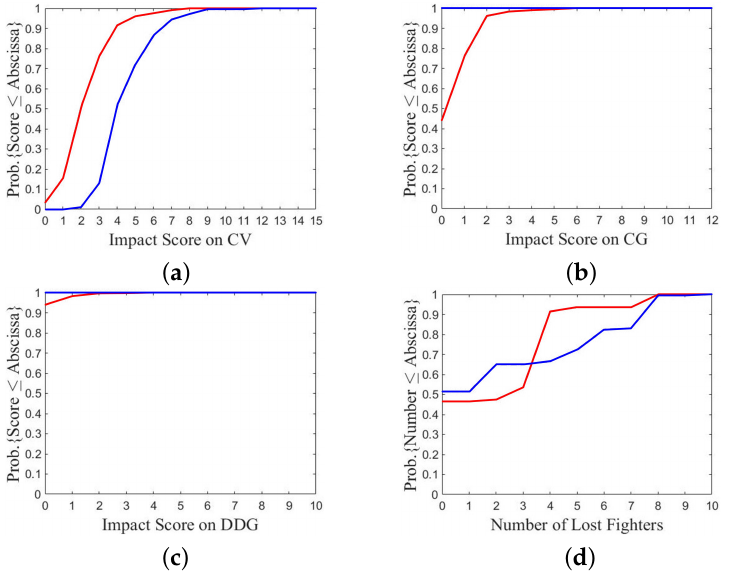
Figure 7. (A2/B3) Cumulative distribution of impact score on ( a ) CV ( b ) CG, ( c ) DDG, ( d ) fighters; over 200 games with two P 2 SO runs, ———: fleet A, ———: fleet